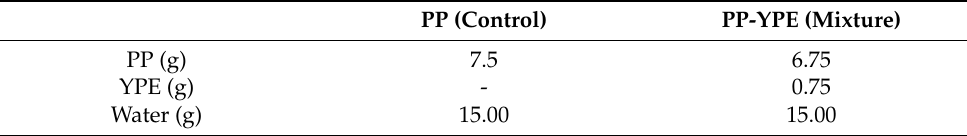
Table 1. Composition of pear pomace (PP) and pear pomace enriched with YPE (PP-YPE). PP (Control) PP-YPE (Mixture) PP (g) 7.5 YPE (g) - 0.75 Water (g) 15.00